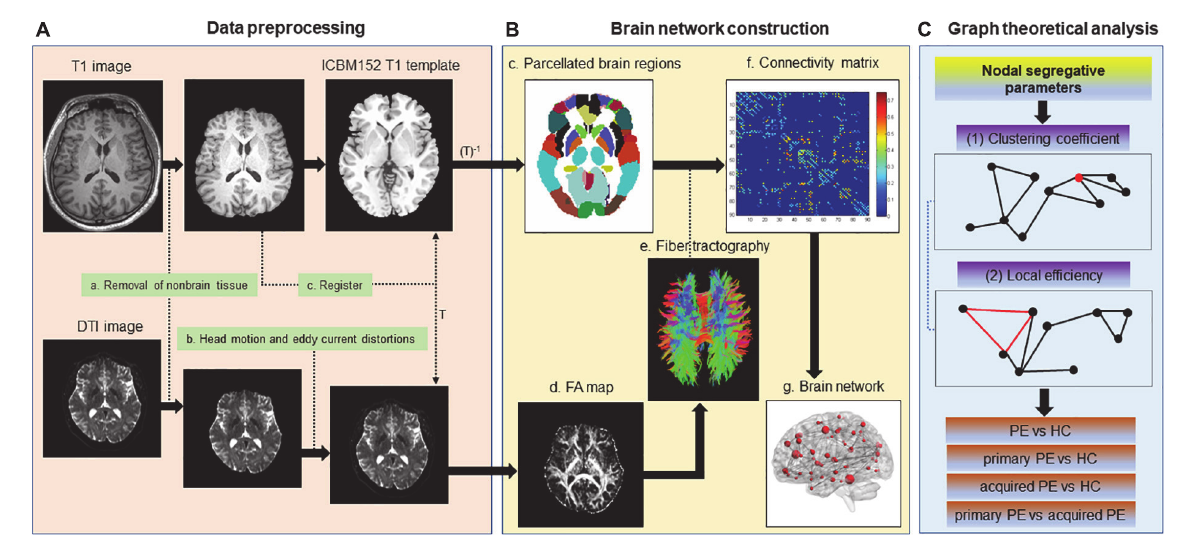
FIGURE1 Flowchart for the construction of the white matter anatomical brain network based on DTI data. Non-brain tissues were removed from T1 and DTI images. Eddy current distortions and head motion artifacts were corrected for DTI data. T1 image was co-registered to the non-diffusion image ( b = 0 image) in DTI native space. The resultant T1 image was registered to the ICBM152 T1 template in the Montreal Neurological Institute (MNI) space, which resulted in a non-linear transformation (T) and an inverse transformation (T − 1 ). T − 1 was applied to the Automated Anatomical Labeling (AAL) template in the MNI space, which resulted in a subject-specific parcellation in the DTI native space. Then diffusion tensors were calculated, FA maps were generated and whole-brain white matter fiber tracking was performed by the probabilistic fiber tracking approach based on DTI data. The weighted connection matrix of 90 AAL regions was created (edges: the average FA of all the voxels along streamlines linking two nodes; nodes: brain regions in AAL template). The weighted white matter anatomical networks were created. Finally, nodal segregative parameters including the clustering coefficient and local efficiency were calculated by the Brain Connectivity Toolbox and comparison of these parameters were performed between